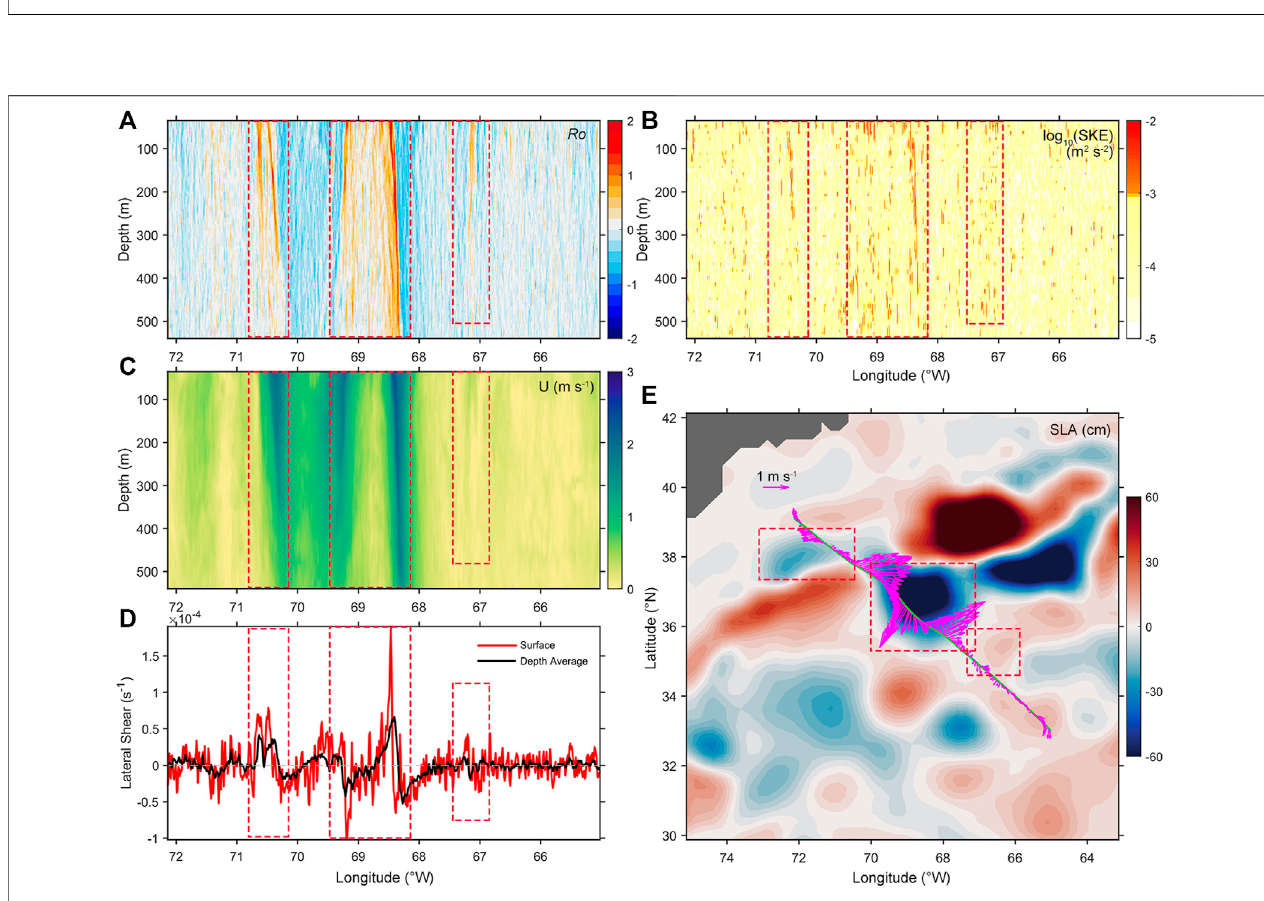
FIGURE 8 | Information of case 201405. (A) Section of Rossby number; (B) section of SKE (m 2 s − 2 ); (C) section of velocity magnitude (m s − 1 ); (D) surface and depth-averaged lateral shear (s − 1 ); (E) SLA map (cm) and surface velocity vector (m s − 1 , magenta arrows); the green curve denotes the section.